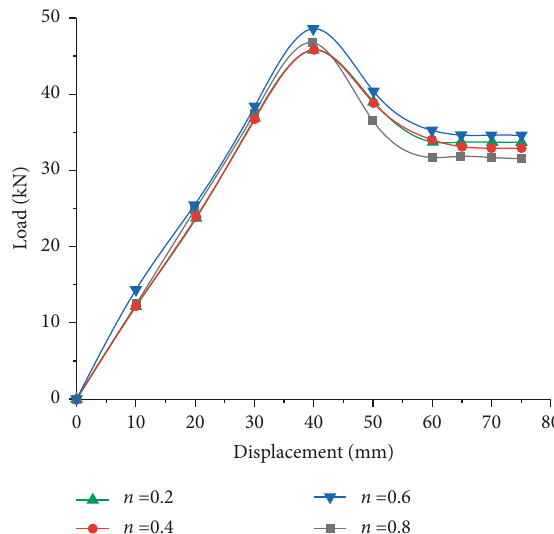
Figure 14: Load-displacement curves of joints with different axial compression